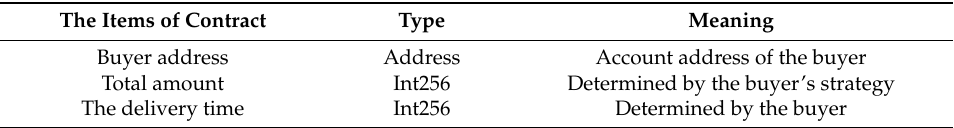
Table 3. Basic elements of a demand order